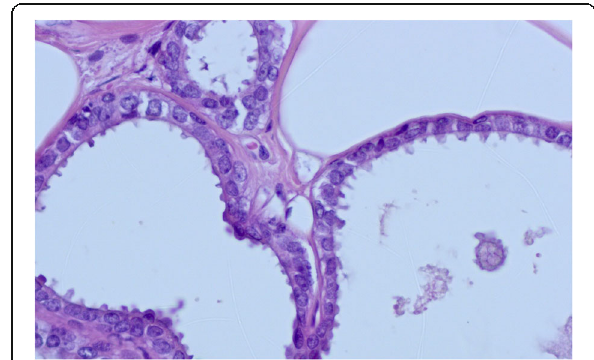
Fig. 6 Flat epithelial atypia showing cellular crowding, coarse calcifications